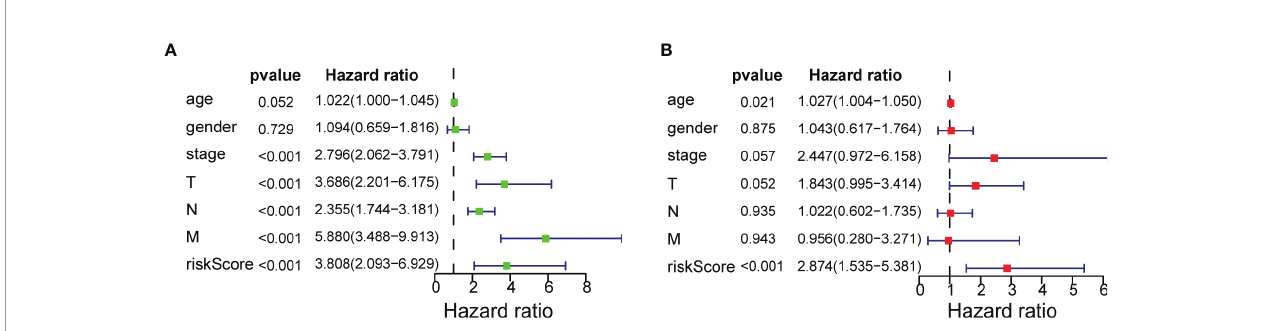
FIGURE 4 | Cox regression analysis of 7-miRNA Risk Score for overall survival in COAD. (A) Univariate analysis. (B) Multivariate analysis.